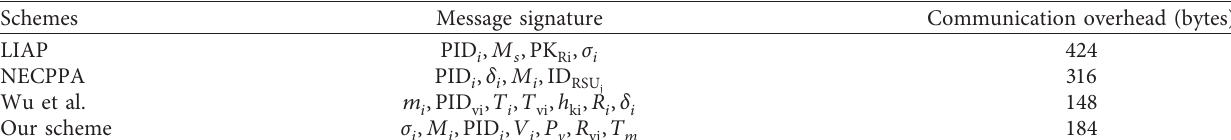
Table 5: Communication cost of message signature in each scheme.